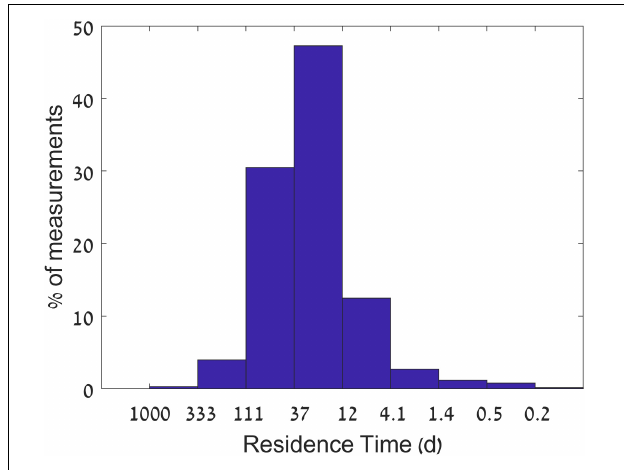
FIGURE 2 | Histogram of estimated residence times from January 2014 to August 2016. Residence times ( X -axis) are calculated from influx measurements assuming a constant estuary volume of 300,000 m 3 . The Y -axis represents the percentage of occurrences.